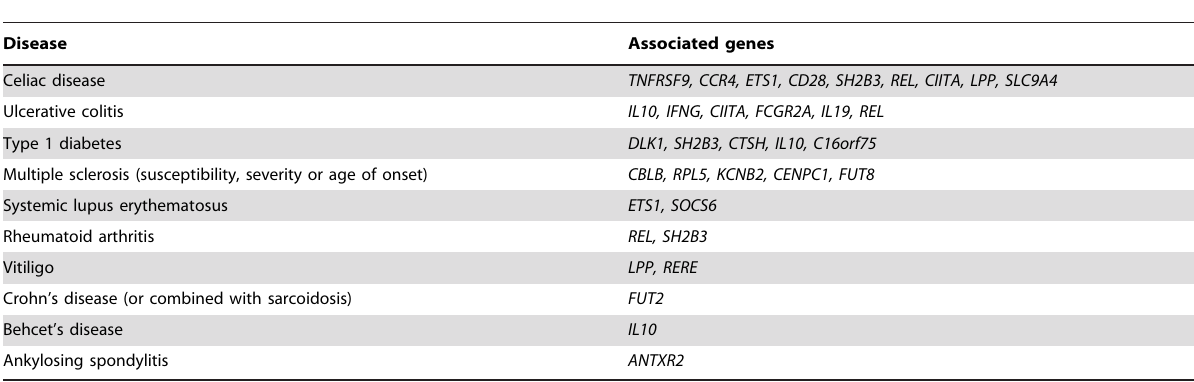
Table 3. Genes correlated with pathogen diversity which have been previously associated to susceptibility to autoimmune